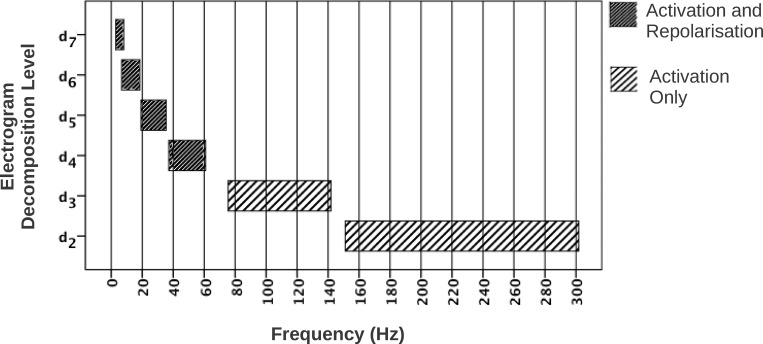
Range of dominant frequencies observed in all sheep at decomposition levels d2 –d8.Electrogram features extracted at levels d1 –d3 correspond to QRS components associated with activation only. Electrogram features extracted at levels d4 –d8 correspond to electrogram features spanning QRS and T wave segments.